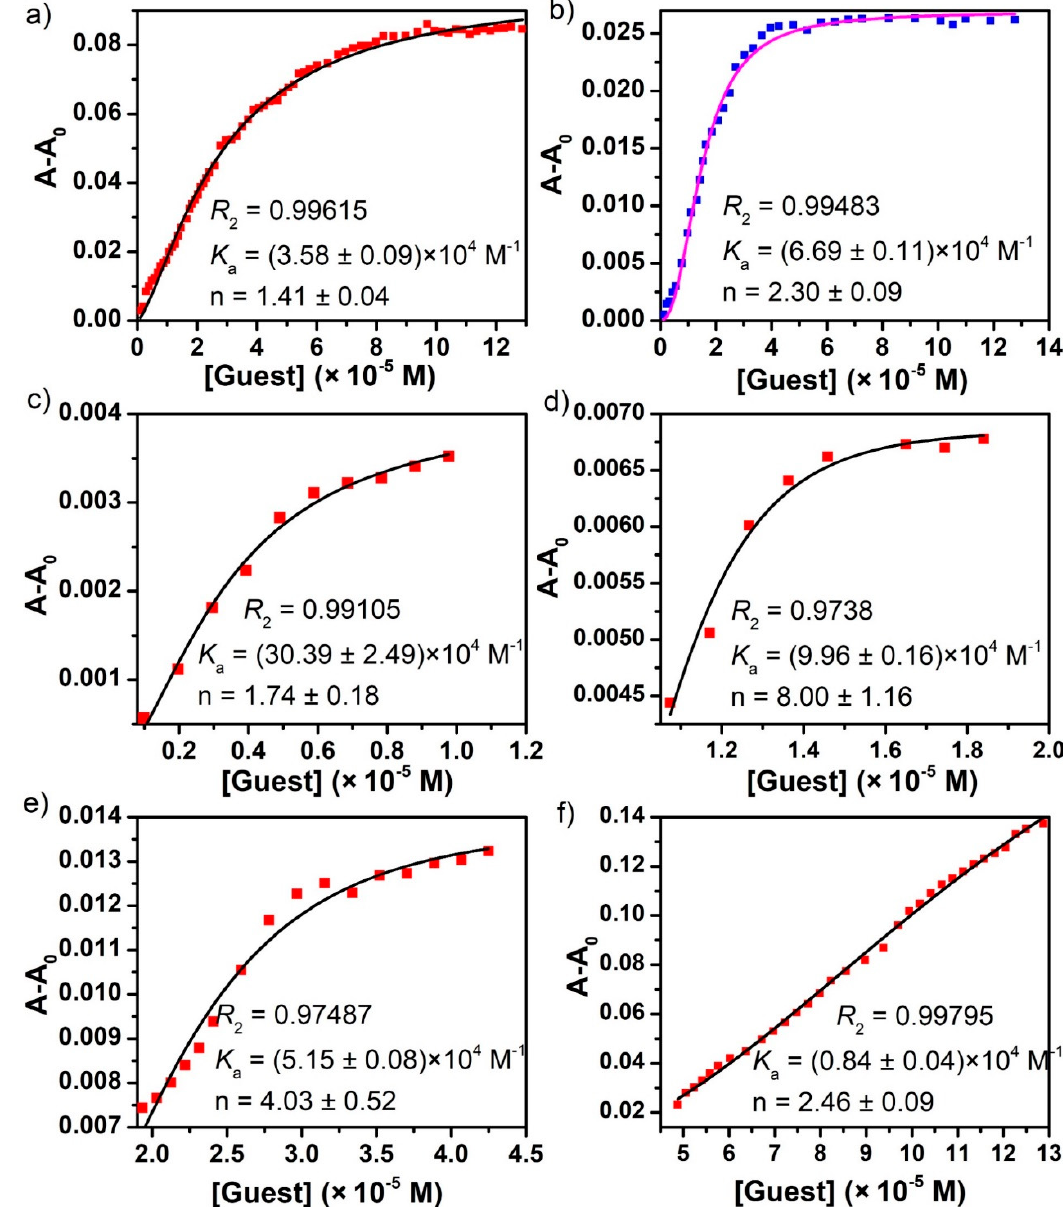
Figure 5. The nonlinear fits to Hill equation of UV-Vis titration experiments based on the absorption band centered at 350 nm for ( a ) D1 ≅ H1 and ( b ) D2 ≅ H1 , and at 370 nm in the [ D1 ]/[ H1 ] ranges of ( c ) 0 − 2, ( d ) 2 − 3, ( e ) 3 − 8, and ( f ) 8 − 23.